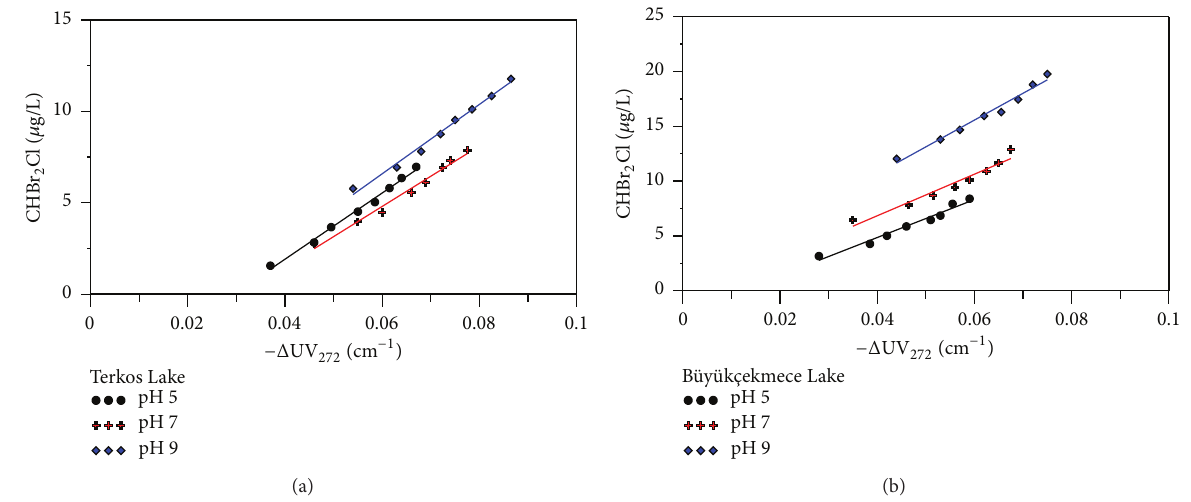
Figure 6: The relationship between CHClBr 2 and Δ UV 272 at different pH and Cl 2 to DOC ratios (a) in chlorinated TL water and (b) in chlorinated BL